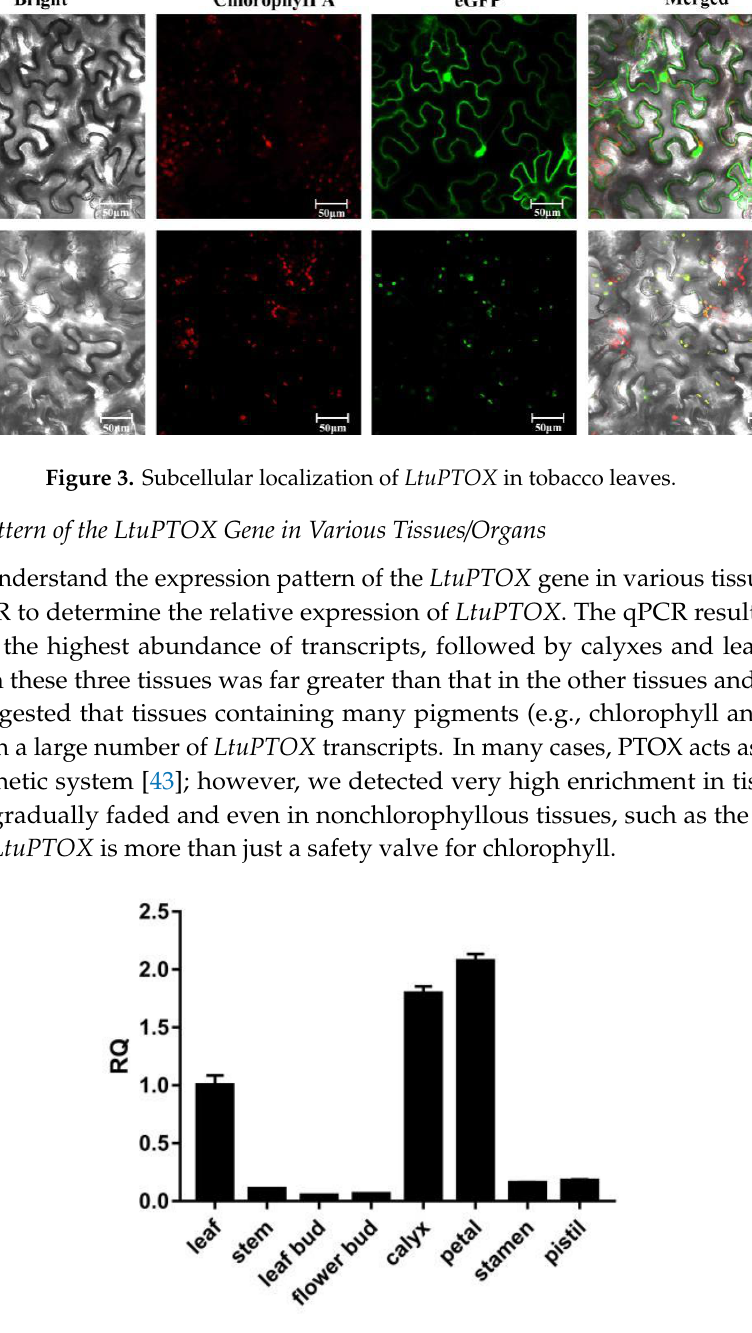
Figure 4. Expression patterns of LtuPTOX in eight tissues/organs.